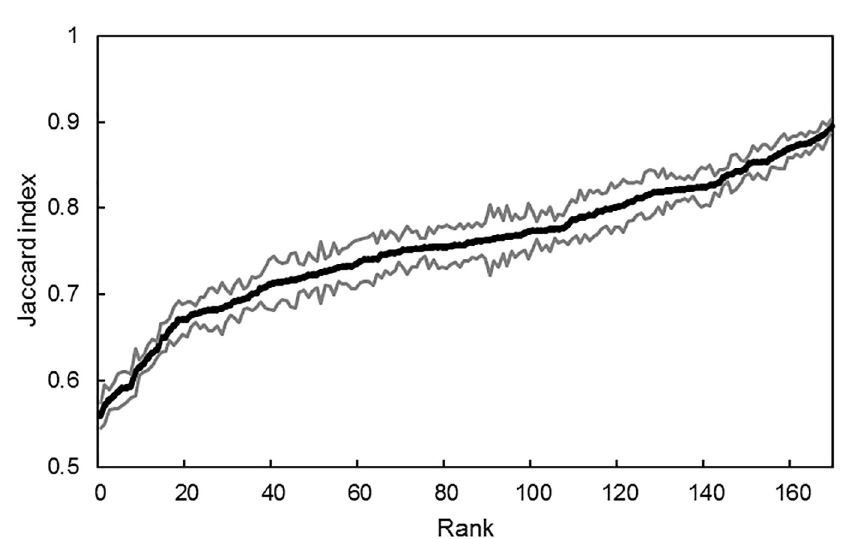
Fig 2. Habitat specialization (Jaccard index) and the standard error around the estimator for 170 plant species. The black center line indicates each plant species’ specialization index value (0 = complete specialist; 1 = complete generalist) and the grey lines are standard deviations. Species are ranked according to their specialization